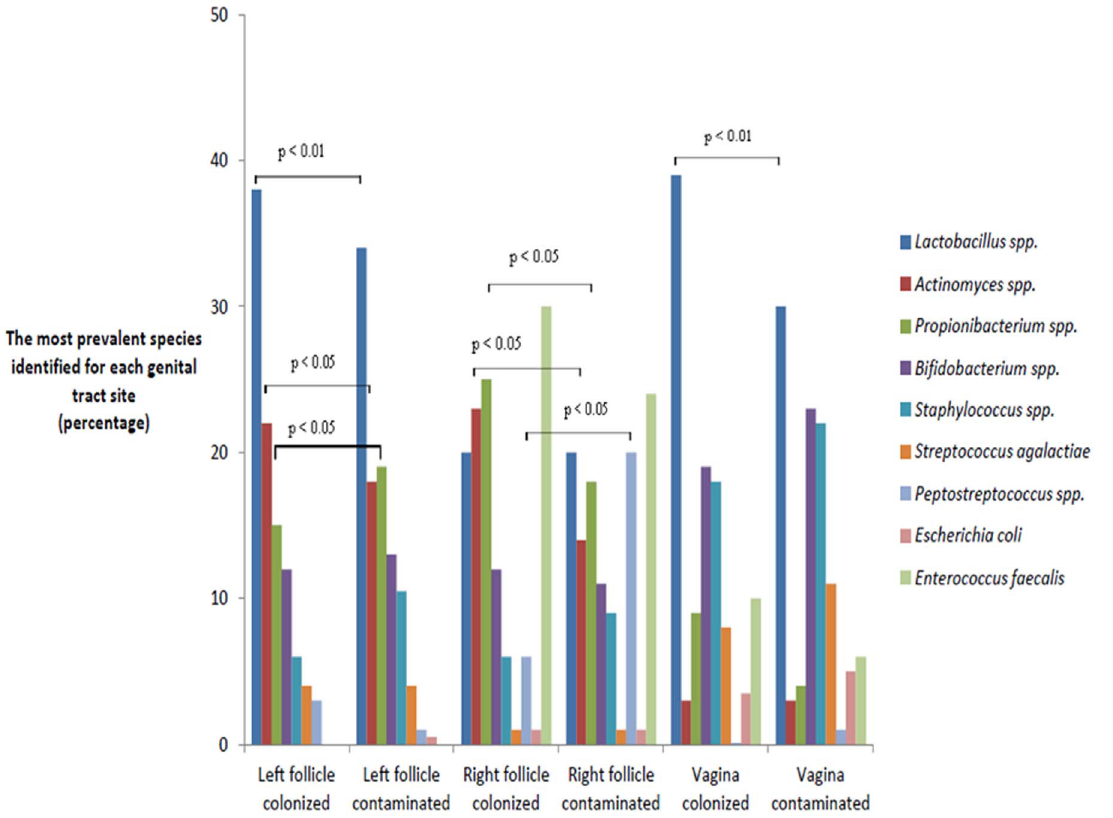
Figure 2. The most prevalent microbial species detected within the left or right follicular fluid and vagina in women with colonized or contaminated follicular fluid. Lactobacillus spp., Actinomyces spp. and Propionibacterium spp. were detected more often in the colonized left follicular fluids than in the contaminated left follicular fluids (p , 0.01, p , 0.05 and p , 0.05 respectively). Actinomyces spp. and Propionibacterium spp. were identified more often in colonized than in contaminated follicular fluids (p , 0.05), while Peptostreptococcus spp. were isolated more frequently from contaminated follicular fluids from the right ovarian follicles (p , 0.05). The vaginal swabs from women with colonized follicular fluid had a higher number of Lactobacillus spp. isolated (p , 0.01) and also a higher number bacterial isolates when compared to women with contaminated follicular fluid specimens (p , 0.05); however, the same species were detected in both groups of women. doi:10.1371/journal.pone.0059062.g002 PLOS ONE |